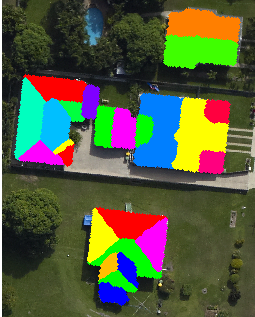
Figure 6: Extracted planar segments after applying a rule-based tree removal method, represented by different colours.